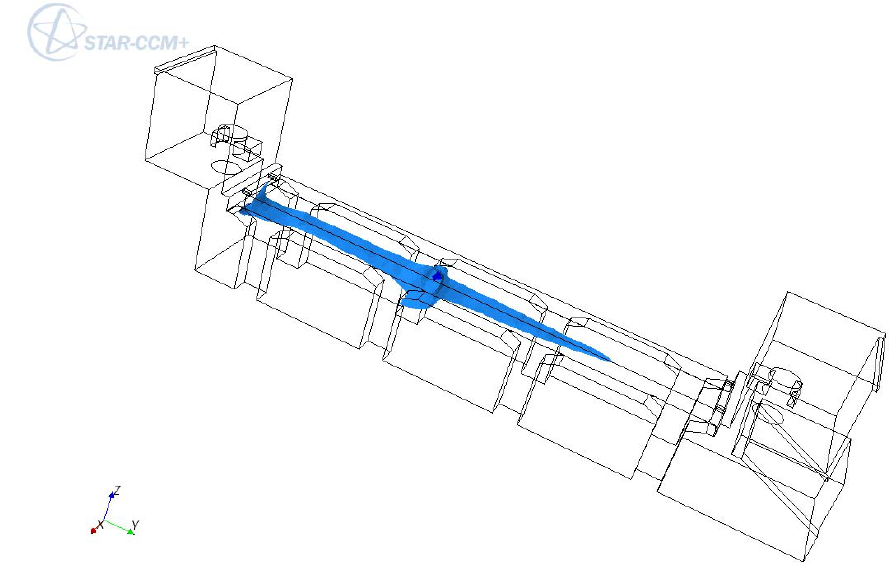
Figure 7. CFD model: LFL and 0.5 LFL concentration iso-surfaces at 600 s from the beginning of the release in coke battery A under the designed ventilation